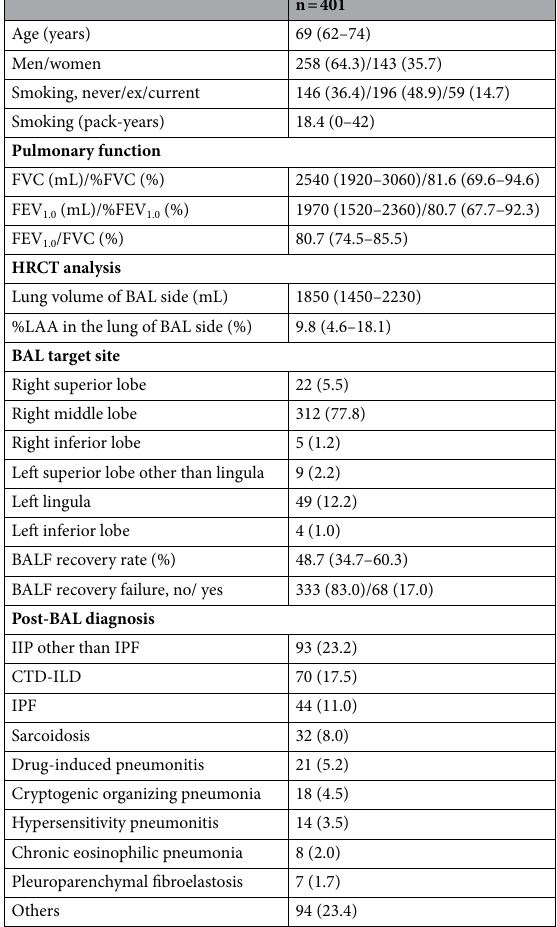
Table 1. Characteristics of derivation cohort. Data are presented as median (IQR), or number (%). FVC forced vital capacity, %FVC percent predicted FVC, FEV 1.0 forced expiratory volume in one second, %FEV 1.0 percent predicted FEV 1.0 , HRCT high-resolution computed tomography, BAL bronchoalveolar lavage, BALF BAL fluid, LAA low attenuation area, IIP idiopathic interstitial pneumonia, IPF idiopathic pulmonary fibrosis, ILD interstitial lung disease, CTD connective tissue